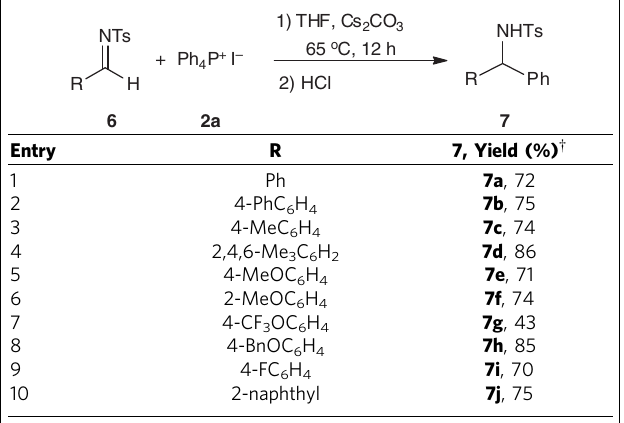
Table 5 | Substrate scope of arylation of 4-phenylbenzaldehyde*.